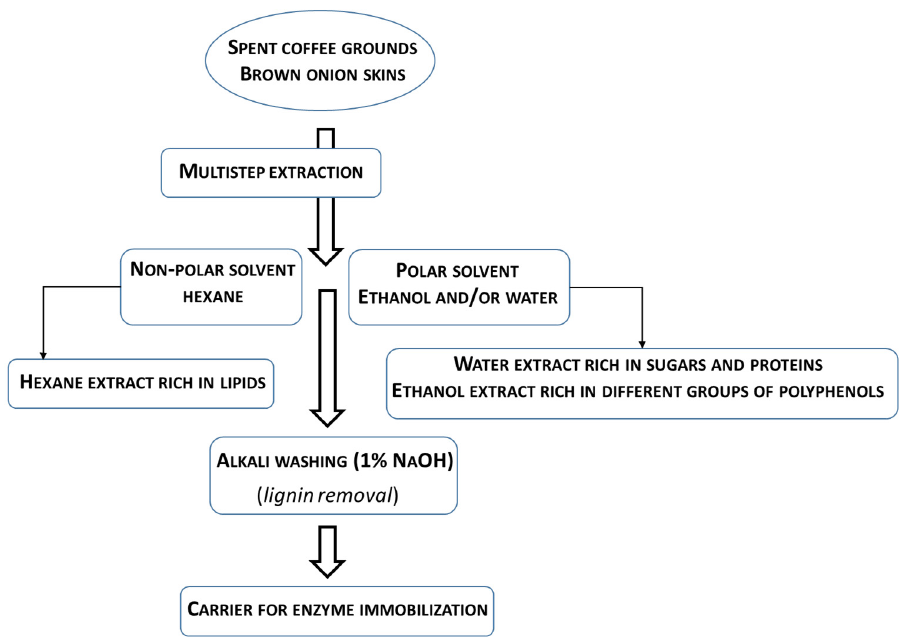
Figure 5. Schematic representation of the transformation of spent coffee grounds and brown onion skins into high-value biological compounds and lignocellulosic material.